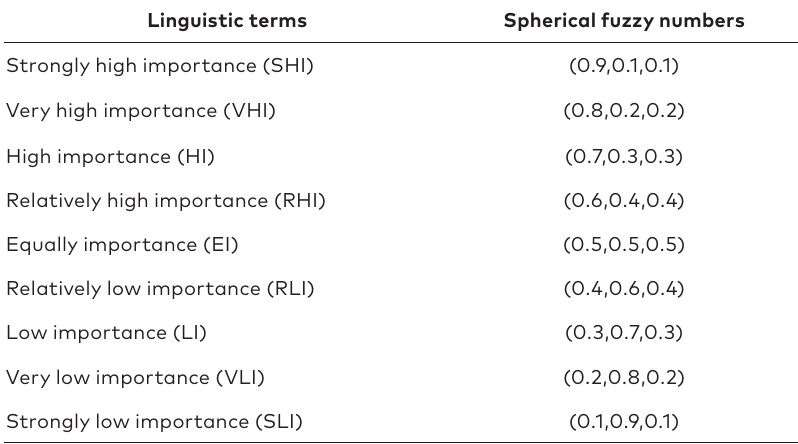
Table 4. Linguistic terms and their corresponding spherical fuzzy numbers